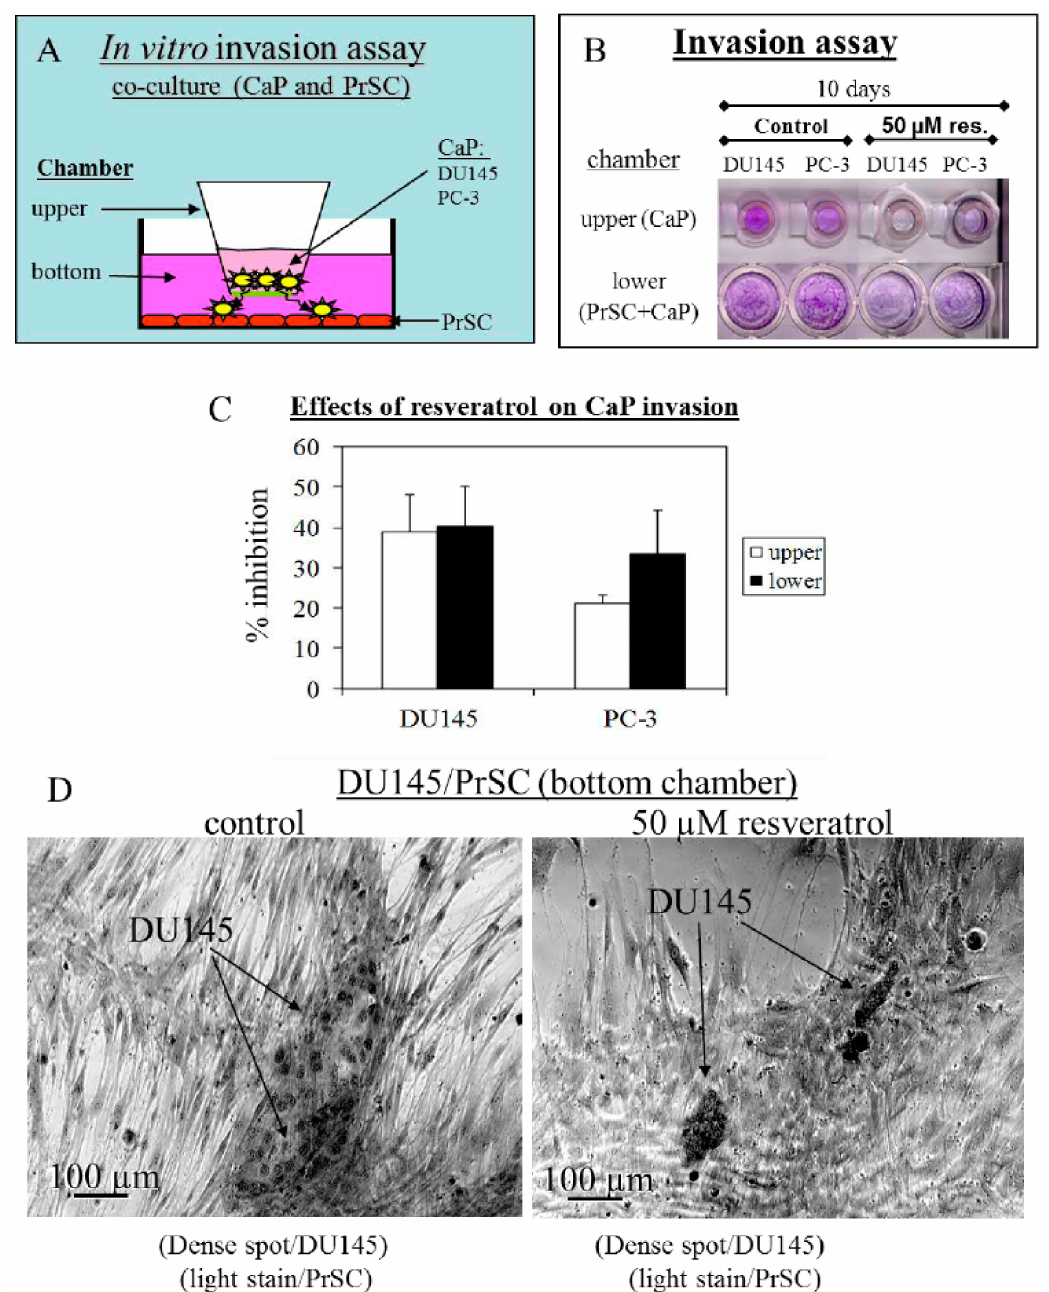
Figure 2. E ff ects of treatment by 50 µ M resveratrol on interaction between prostate stromal and DU145 and PC-3 epithelial tumor cells. ( A ) Boyden chamber was used to study migration of epithelial tumor cells. ( B) Photographs of crystal violet stained cells in the upper and lower chambers, respectively, support that resveratrol inhibits cell motility. ( C ) Quantitation of e ff ects of resveratrol on CaP cell invasion was determined by extracting the dye-stained cells with 1% acetic acid and measuring OD 570 . ( D ) Intensity and morphology of dye-stained cells show resveratrol inhibits migration of DU145 cells across the Matrigel